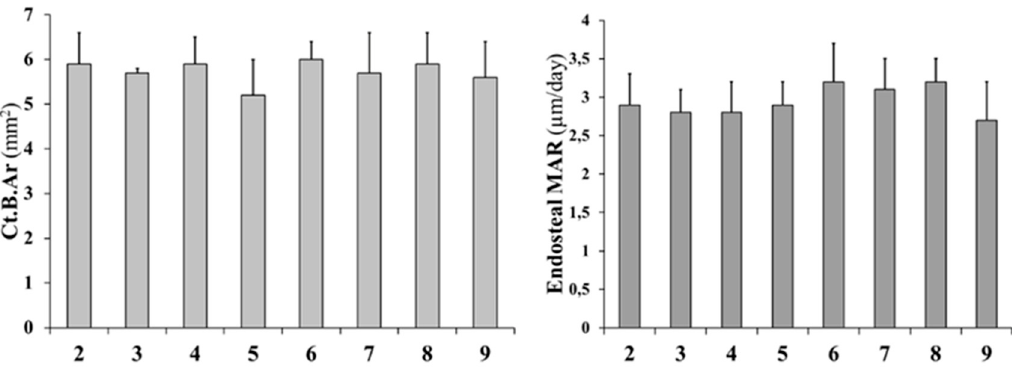
Figure 11. Static and dynamic histomorphometric parameters of cortical bone in femoral distal metaphyseal sections. Ct.B.Ar: cortical bone area; MAR: mineral apposition rate. Values are expressed as mean ± S.D. ANOVA followed by Bonferroni’s test.